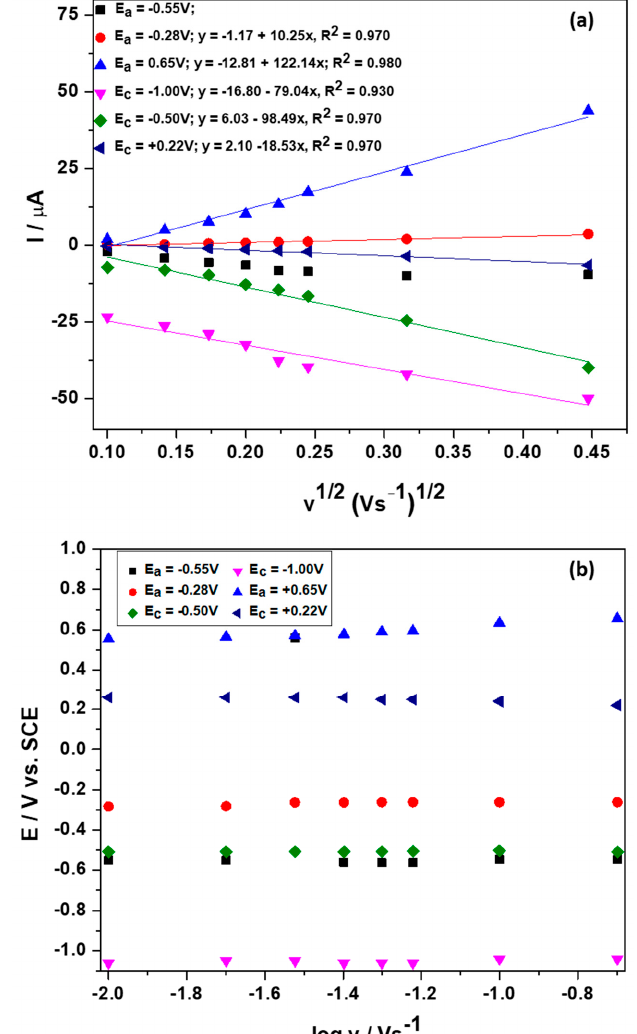
Figure 7. ( a ) Linear dependence of the peaks currents vs. square root of the scan rate; ( b ) Dependence of the peak potentials vs. the logarithm of the scan rate.